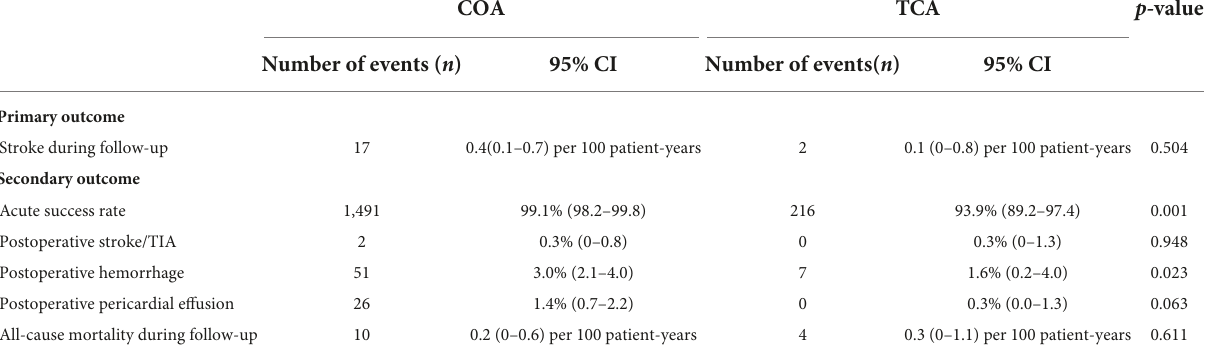
TABLE 3 Differences in outcomes and complications between COA and TCA studies.